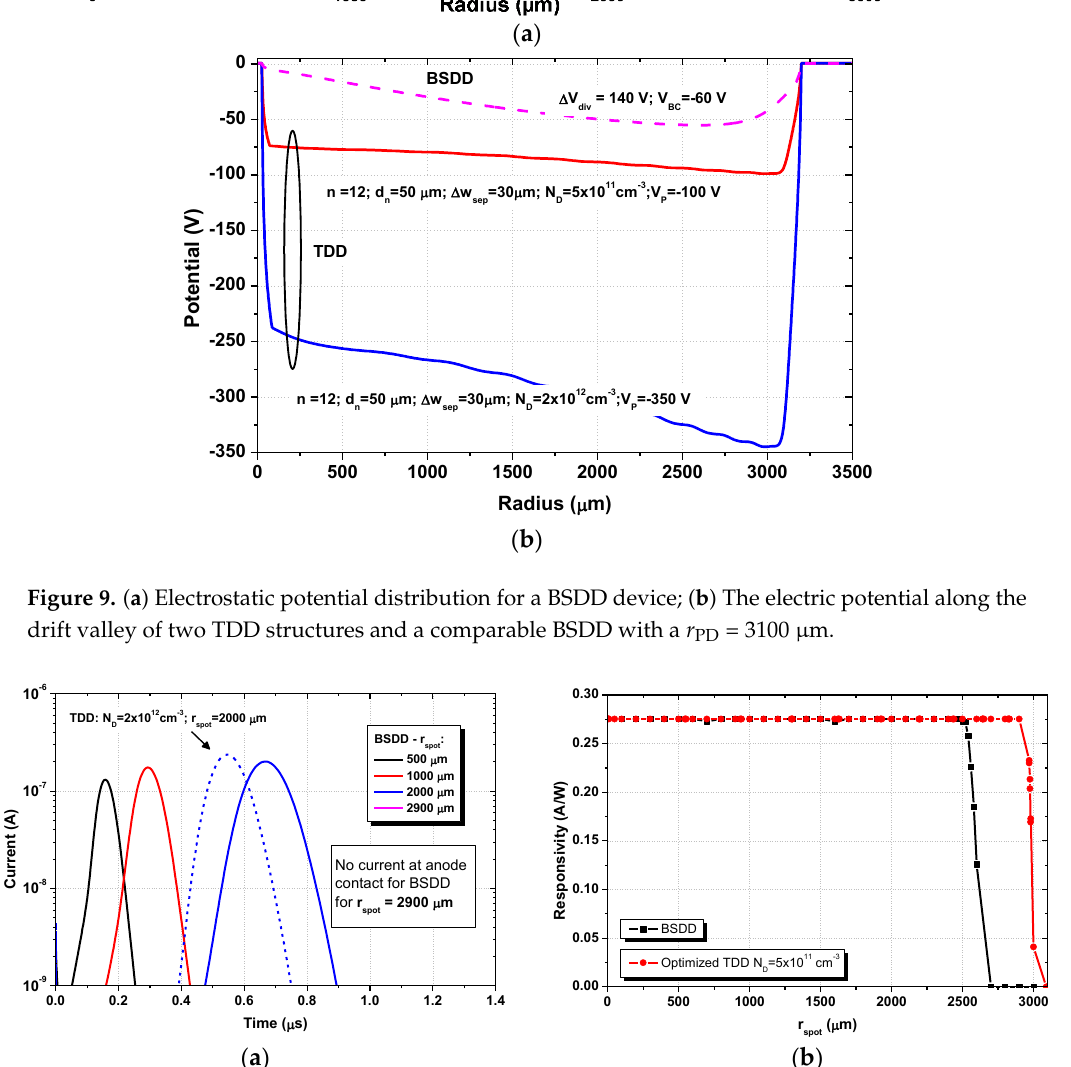
Figure 9. ( a ) Electrostatic potential distribution for a BSDD device; ( b ) The electric potential along the drift valley of two TDD structures and a comparable BSDD with a r PD = 3100 µm.